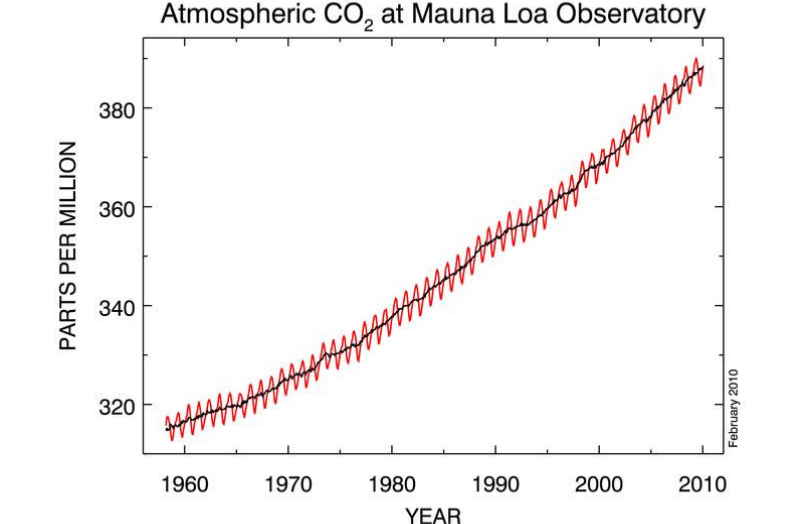
on human health 2